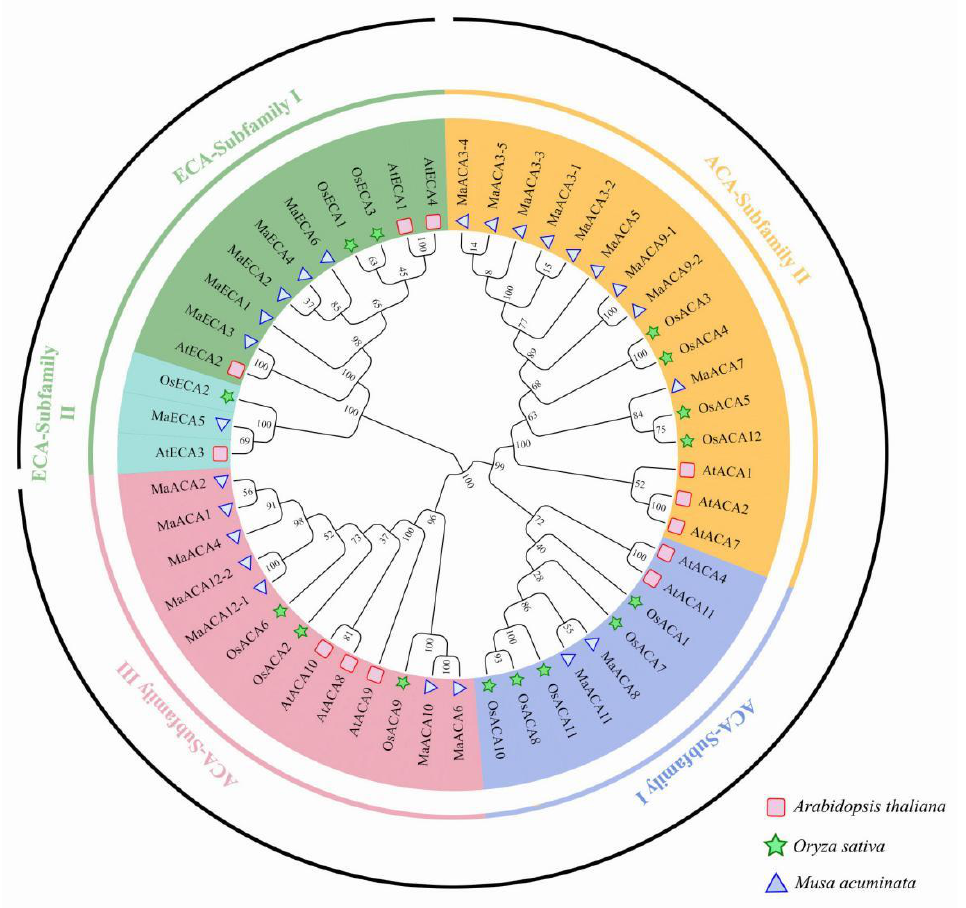
Figure 2. Phylogenetic analysis results based on the Ca 2+ -ATPases from Arabidopsis thaliana (At), Oryza sativa (Os) and Musa acuminata (Ma). Subfamily I-Subfamily V represents different Ca 2+ -ATPase subfamily, respectively.